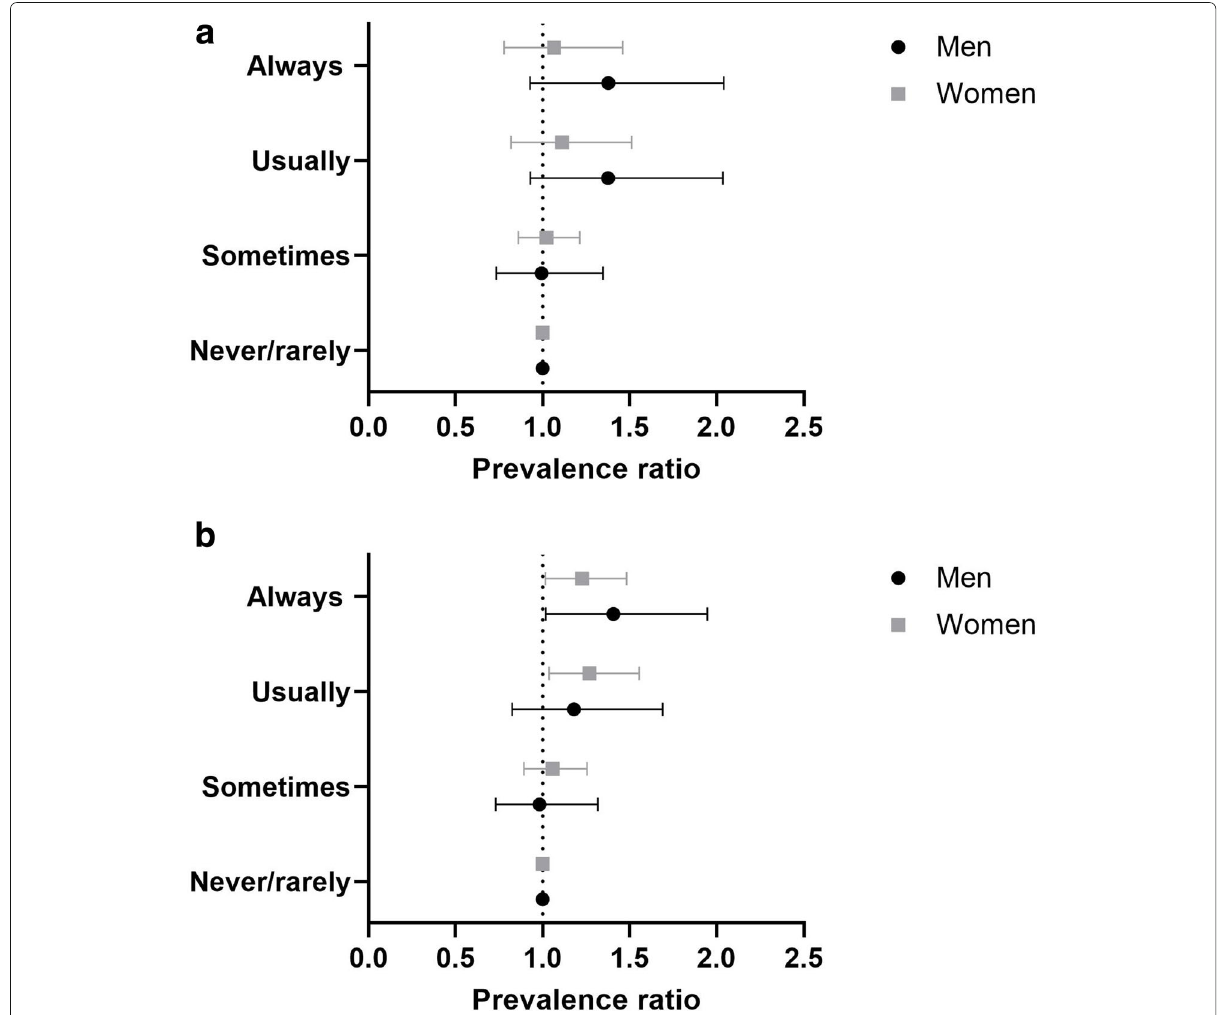
Fig. 4 Forest plot illustrating the prevalence of migraine among different occupational categories, divided by work-related physical activity. Mean with error bars plots of the data from Table 4. The point estimate is the prevalence ratio (fully adjusted model) of migraineurs compared with controls among job categories, differentiated by the relevance and frequency of (a) heavy manual or physical work and (b) walking or standing